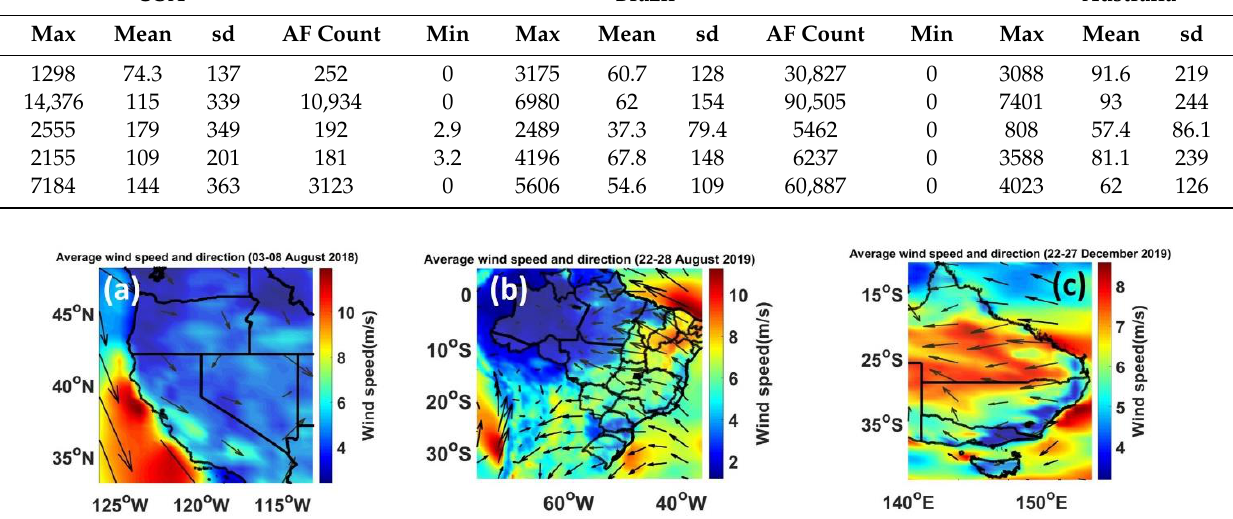
Figure A1. Average wind speed, Ws , and direction, Wd , in ( a ) the western USA, ( b ) Brazil and ( c ) eastern Australia.